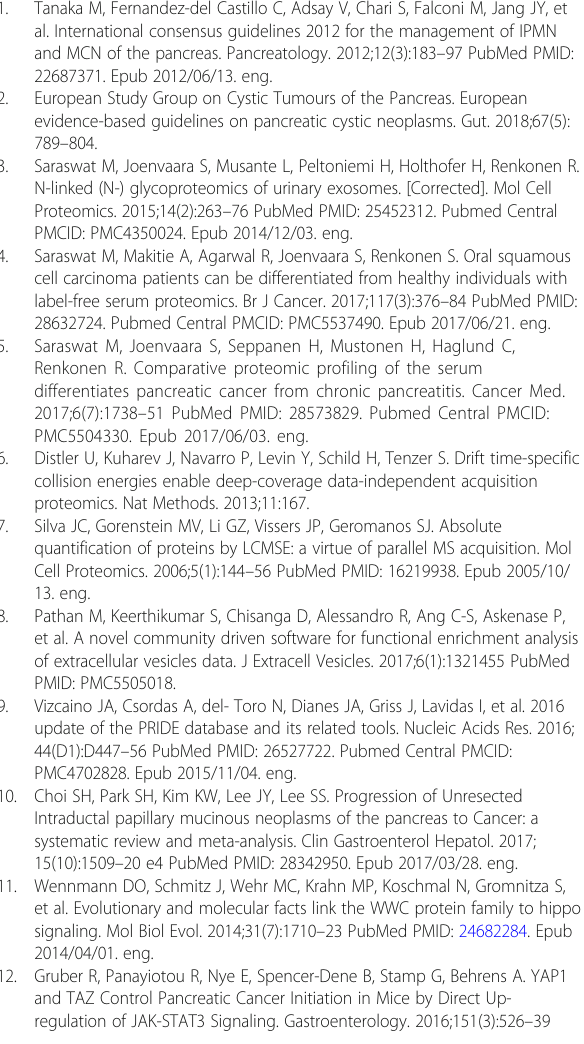
comparison. Table S2. S-Plot proteins of CTRL vs LG. Table S3. S-Plot proteins of CTRL vs HG. Table S4. S-Plot proteins of CTRL vs IPMNC. Table S5. S-Plot proteins of LG vs IPMNC. Table S6. S-Plot proteins of HG vs IPMNC. Table S7. Pathway list of ANOVA passing proteins. (XLSX 337